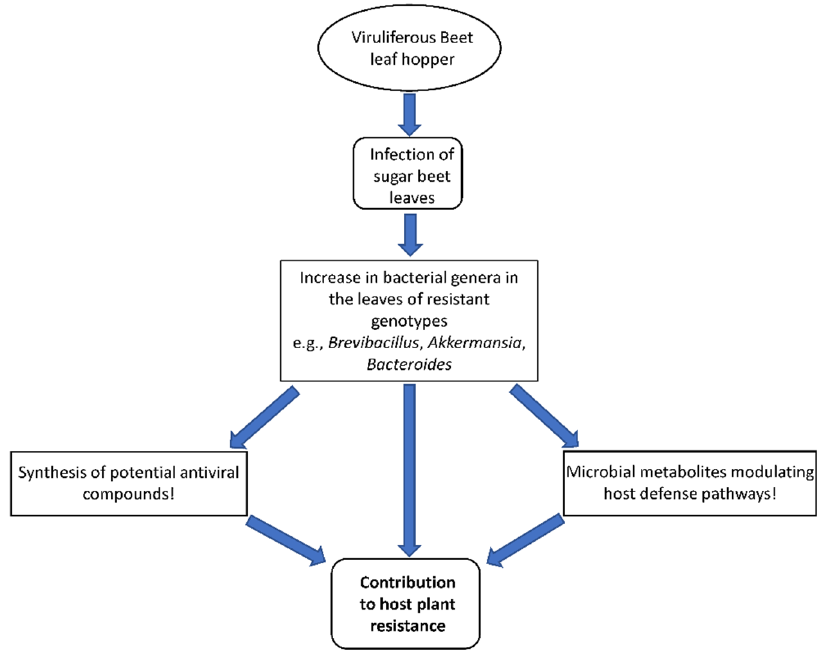
Figure 10. Proposed role of leaf-bacterial-microbiome-mediated sugar beet resistance against beet curly top virus in the virus-resistant genotypes.